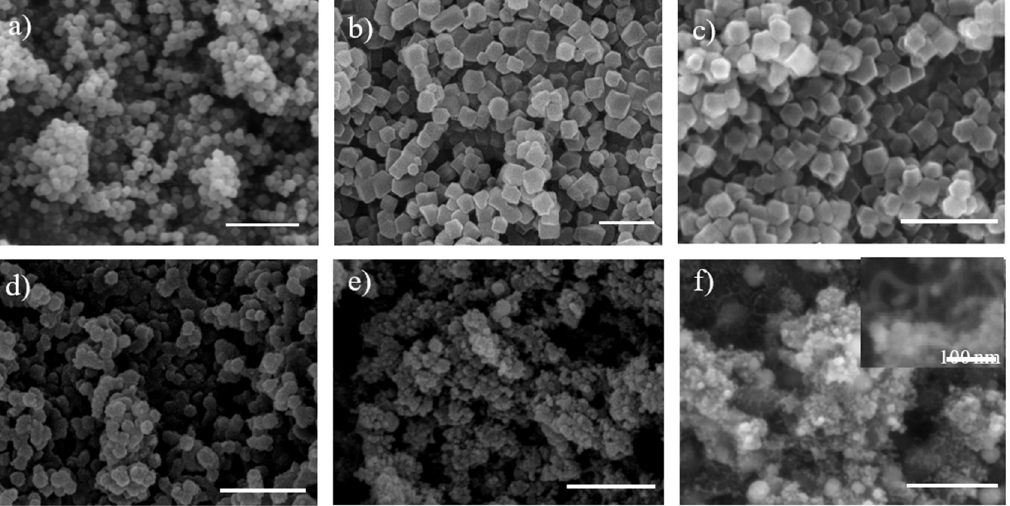
Figure 2. The morphology of the ZIF templates as-synthesized: ( a ) ZIF-8, ( b ) ZnCo-ZIF, ( c ) ZIF-67 and after pyrolysis: ( d ) Zn/CN, ( e ) ZnCo/CN, ( f ) Co/CN. The scale bar is 500 nm.